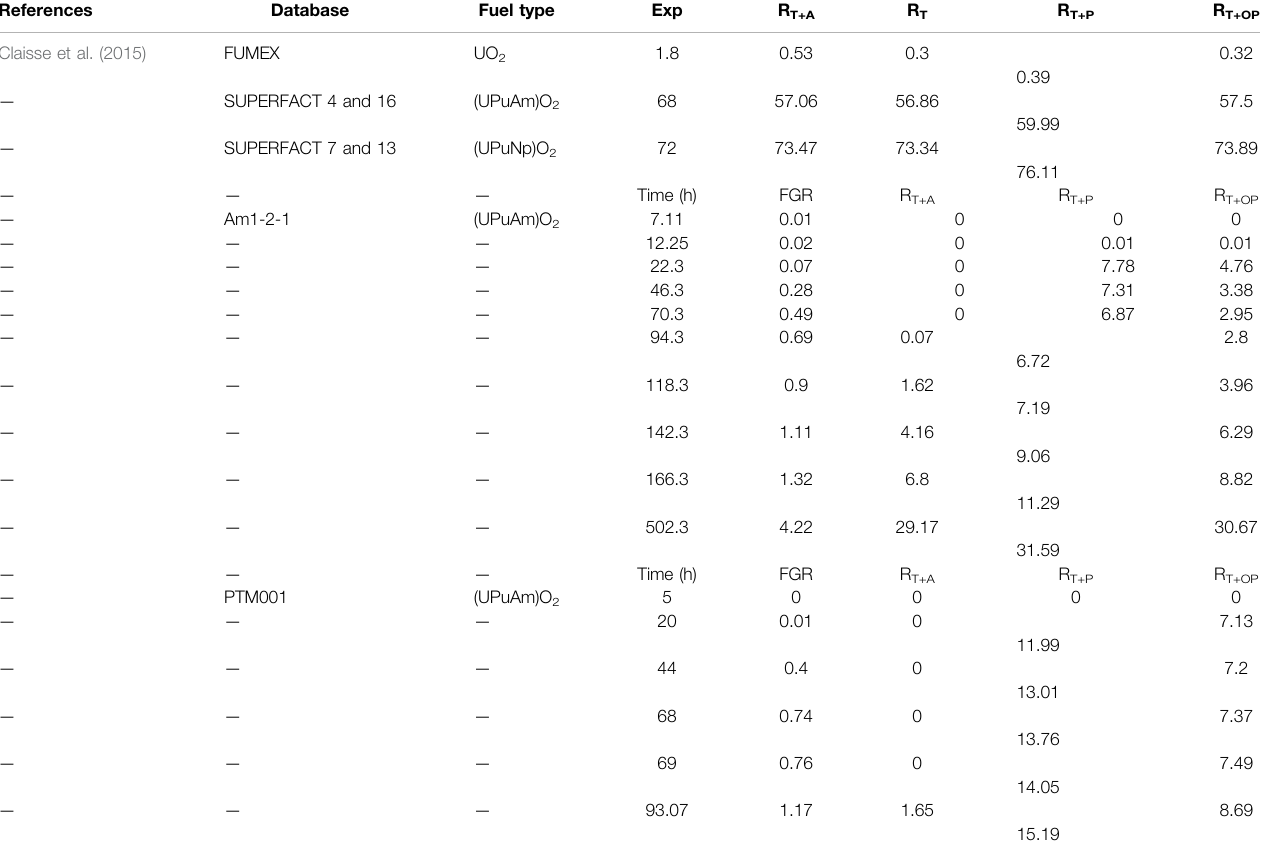
TABLE 4 | Fission gas released (%) in the FUMEX project of the IAEA, the SUPERFACT irradiation experiment, the JOYO irradiation, and the FUMEX project of the fuel rod Am1-2-1 (Claisse et al., 2015).